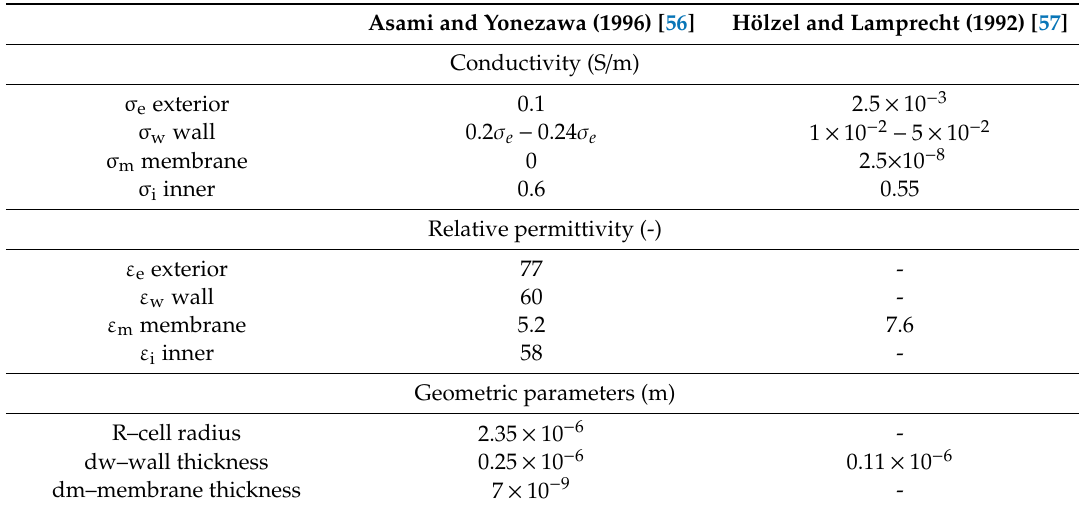
Table 5. Comparison between the values obtained by Asami (1996) [56] and Hölzel (1992) [57].